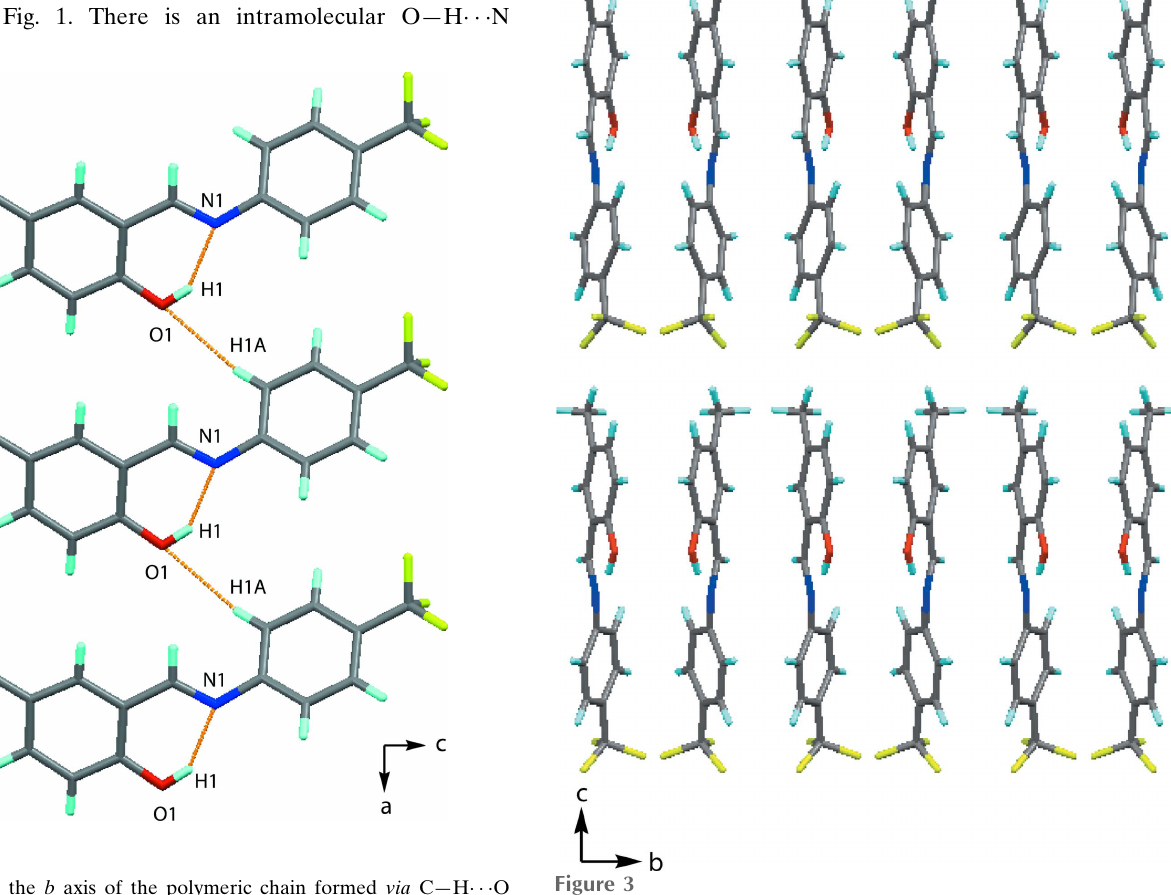
Figure 3 A view of the crystal packing along the a